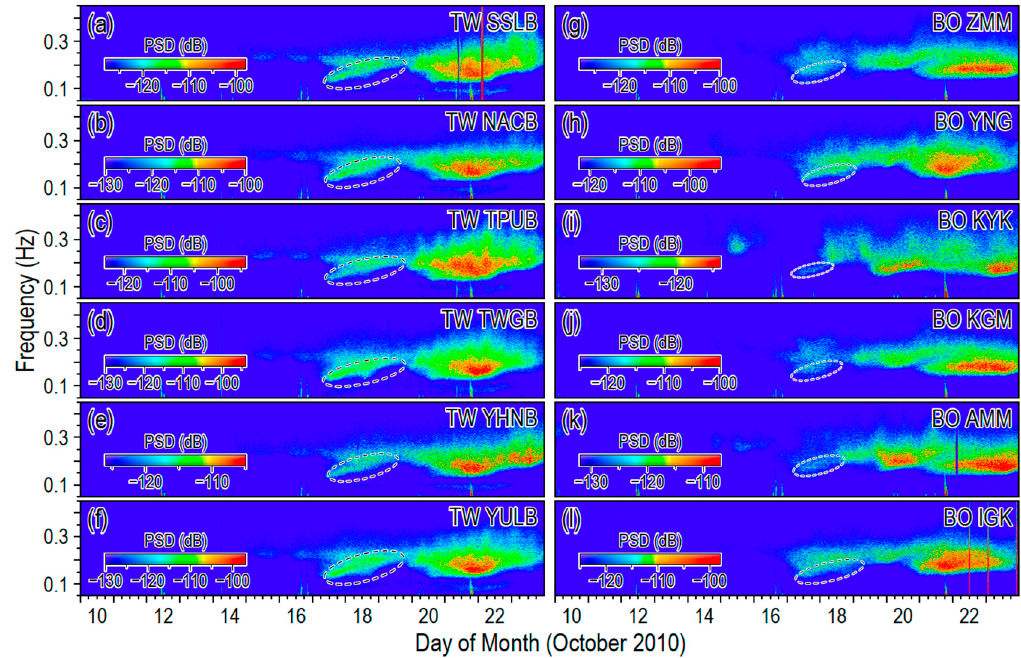
Figure 2. Spectrograms of microseisms from Typhoon Megi recorded by seismic stations (vertical component) on ( a – f ) Taiwan and ( g – l ) the Ryukyu Islands. The dashed ellipses outline Class-II (dispersive double-frequency (DF)) microseisms generated in coastal regions. Color scales vary from plot to plot to emphasize the dispersive characteristics of the DF microseisms at each station. The scaling unit (dB) corresponds to 10 · log m 2 /Hz 10